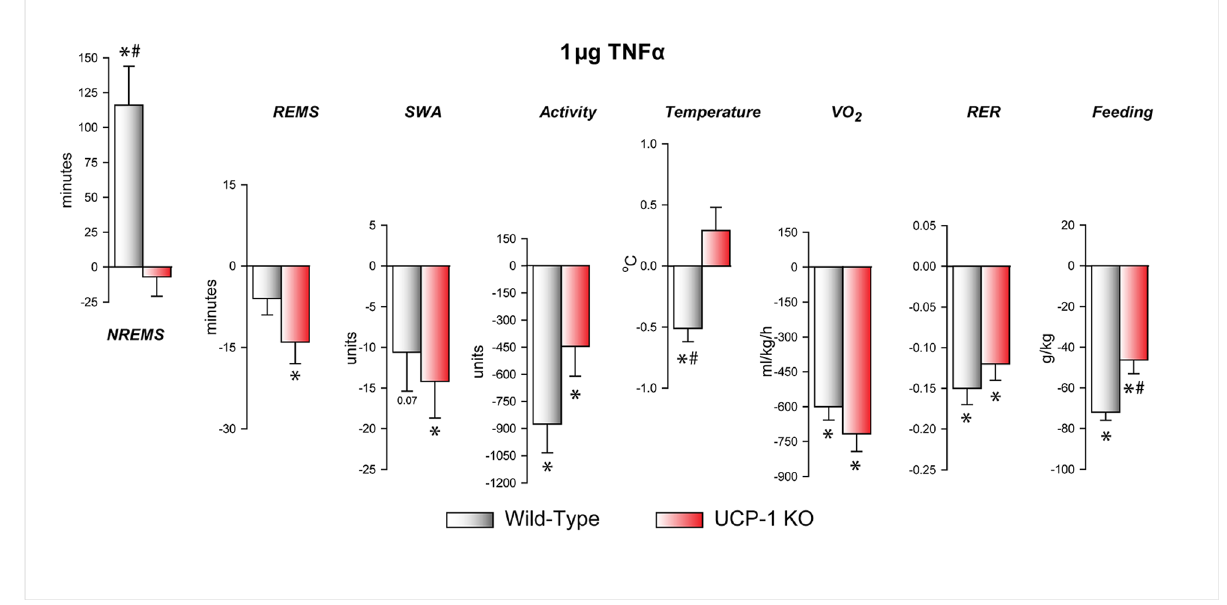
Fig 4. The effects of 1 μ g TNF α on NREMS, REMS, slow-wave activity of the electroencephalogram (SWA) body temperature, oxygen uptake (VO 2 ), respiratory exchange ratio (RER) and food intake in WT and UCP-1 KO mice. Data are expressed as change from baseline in the first 12 h after treatments. See legends to Fig 1 for details.